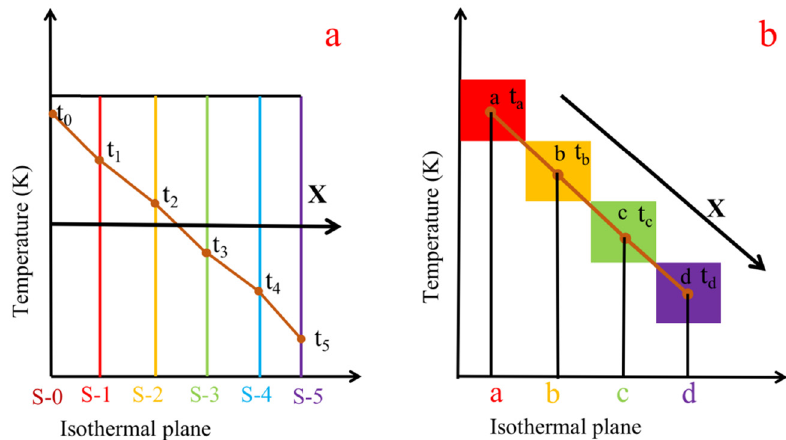
Figure 2: Schematic diagram of thermal transfer direction of PP composites: ( a ) di ff erent isothermal planes and ( b ) di ff erent regions of the same isothermal